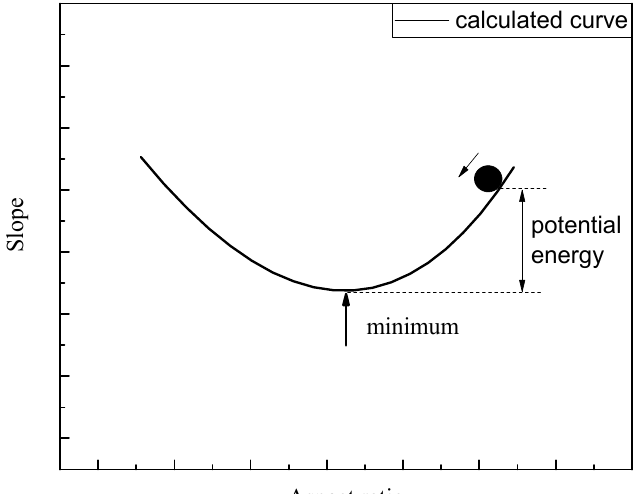
Figure 11. Schematic of the channel adjustment under equilibrium water and sediment transport.